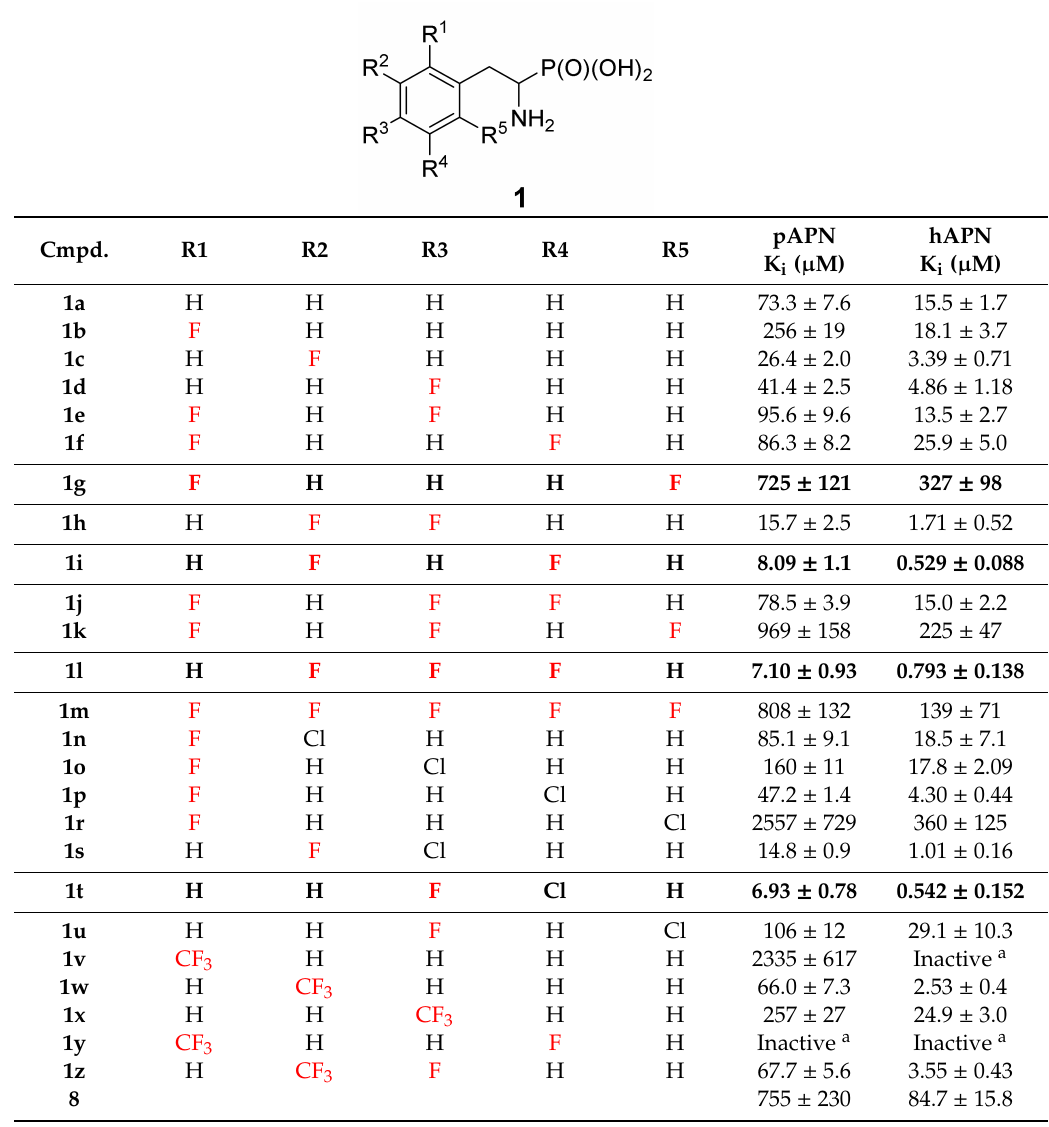
Table 1. Inhibitory activity of phosphonic acid analogs of fluorine substituted phenylalanines.